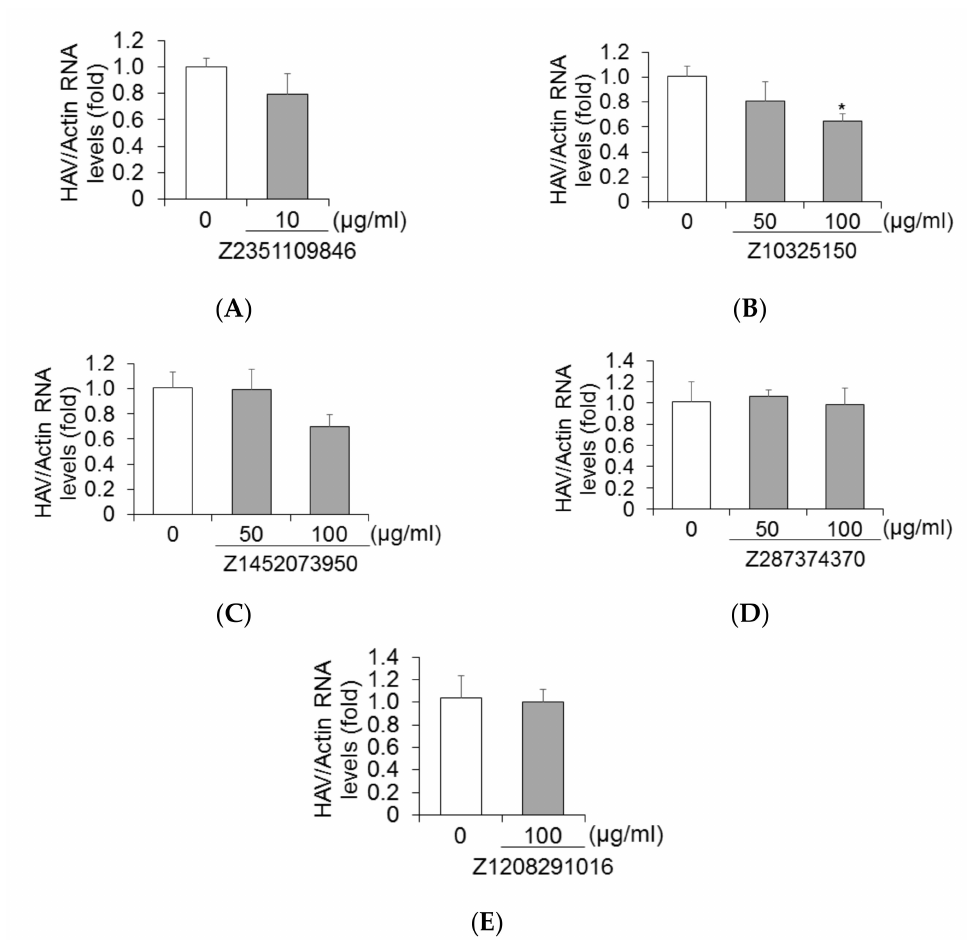
Figure 5. Z10325150 could inhibit HAV genotype IIIA HA11-1299 replication. Huh7 cells infected with HAV genotype IIIA HA11-1299 were treated with Z2351109846 ( A ), Z10325150 ( B ), Z1452073950 ( C ), Z287374370 ( D ), and Z1208291016 ( E ) for 72 h. HAV RNA levels were measured using real-time RT-PCR. Actin mRNA was used as an internal control. Data are presented as the means and standard deviations of triplicate determinations from at least three independent experiments. Statistical significance was analyzed using the two-tailed Student’s t -test: * p <